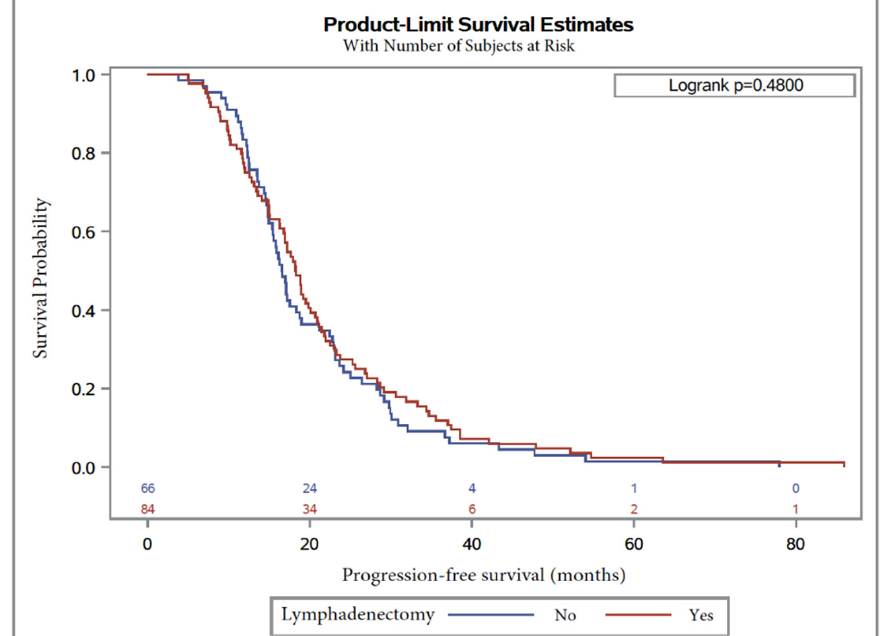
Figure 3. Progression-free survival in patients with serous ovarian carcinoma after NAC with or without lymphadenectomy.